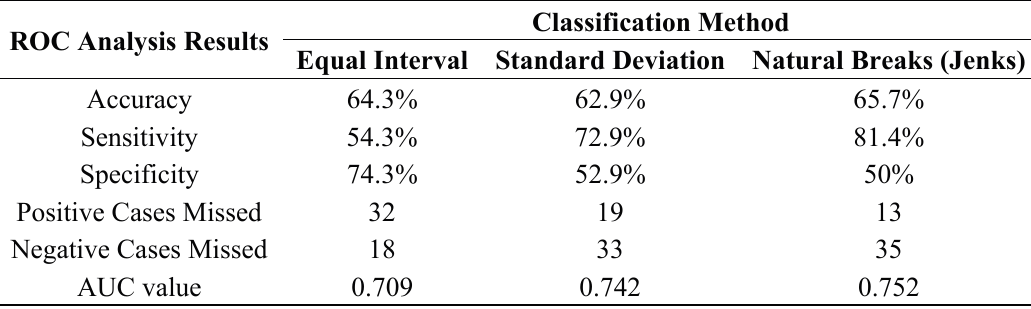
Table 3. ROC analysis results for the classification